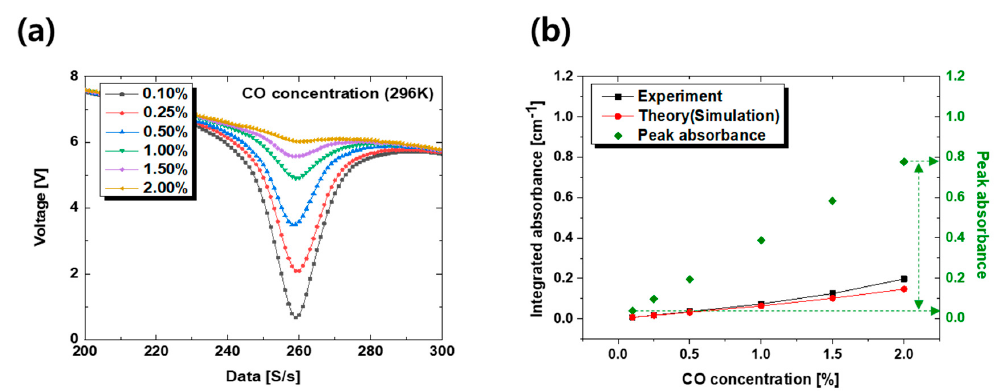
Figure 4. ( a ) Measured CO absorption signal of the preliminary experiment at 296 K. ( b ) Comparison of the experimentally obtained integrated absorbance with that obtained through Voigt simulation for the analysis of detection limit in the preliminary experiment.